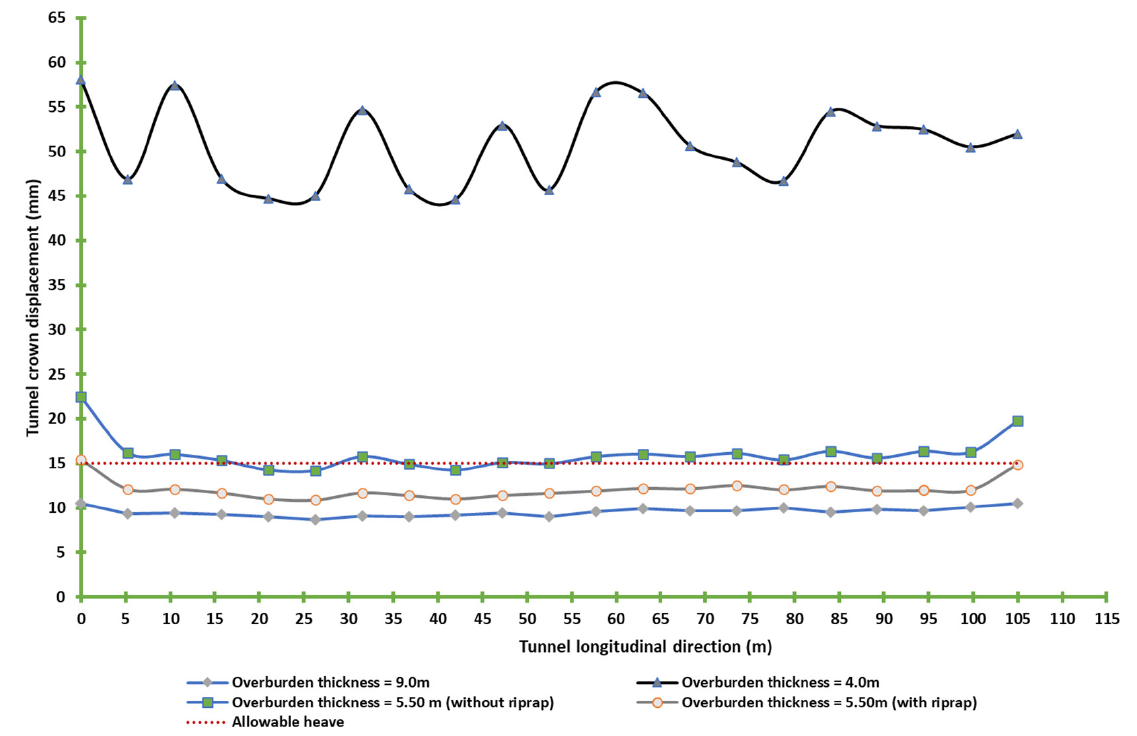
Figure 16. Displacement of tunnel crown during construction.